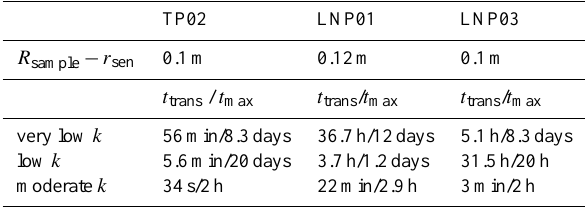
Table 3. Transient and maximum measurement times calculated for the different conductivity and sensor